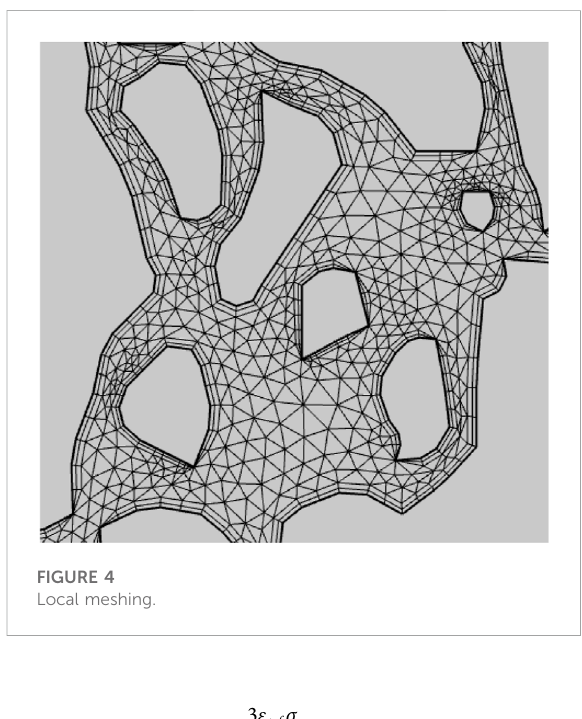
FIGURE 4 Local meshing.